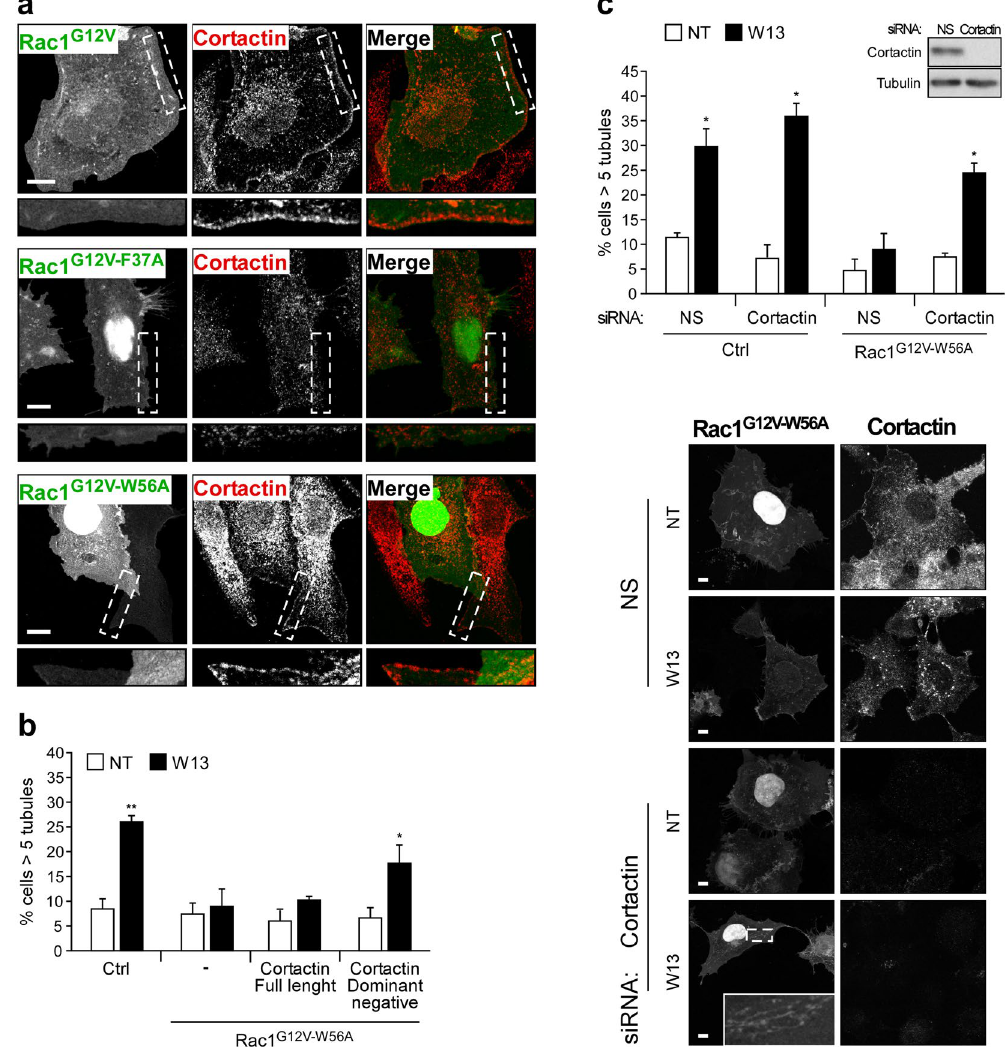
Figure 5. Cortactin is involved in Rac1-dependent tubule inhibition. ( a ) Vero cells grown on coverslips were transfected with GFP-Rac1 G12V , GFP-Rac1 G12V-F37A , or GFP-Rac1 G12V-W56A . After fixation, immunofluorescence was performed to detect endogenous cortactin using an antibody and the corresponding Alexa-555 anti-mouse secondary antibody. Magnification insets show the presence or absence of cortactin at the PM (bars, 10 µ m). ( b ) Percentage of COS1 cells presenting tubules, after W13 treatment, in cells transfected with cherry-Rac1 G12V-W56A alone or co-transfected with full length cortactin or with a cortactin mutant lacking the PH and SH3 domains, acting as a dominant negative. ( c ) The percentage of cells presenting more than 5 tubules per cell was quantified in untreated (NT) and W13-treated cells co-transfected with GFP-Mem or GFP-Rac1 G12V-W56A and the non- specific (NS) or cortactin siRNAs (48 h). Downregulation of cortactin expression by its specific siRNA is shown by western blotting. The W13-induced tubules and cortactin downregulation in GFP-Rac1 G12V-W56A and cortactin siRNA-transfected cells is shown by immunofluorescence as in ( a ) (bars, 10 µ m). Mean values ± standard error of the mean (SEM) from three independent experiments are shown in all cases. Statistical significance between different conditions was determined by Student’s t -test, * p < 0.05, ** p <